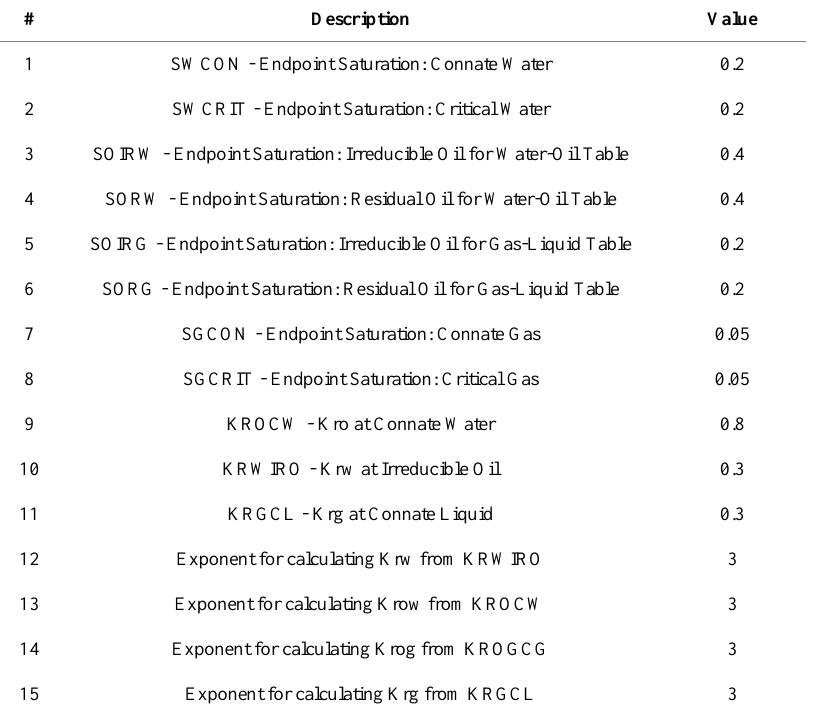
Table 5. End point saturations used in CMG for generation of relative permeability curves